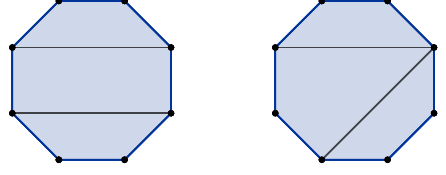
Figure 3 . Planar Feynman diagrams for 5 particles in φ 3 + φ 4 theory.